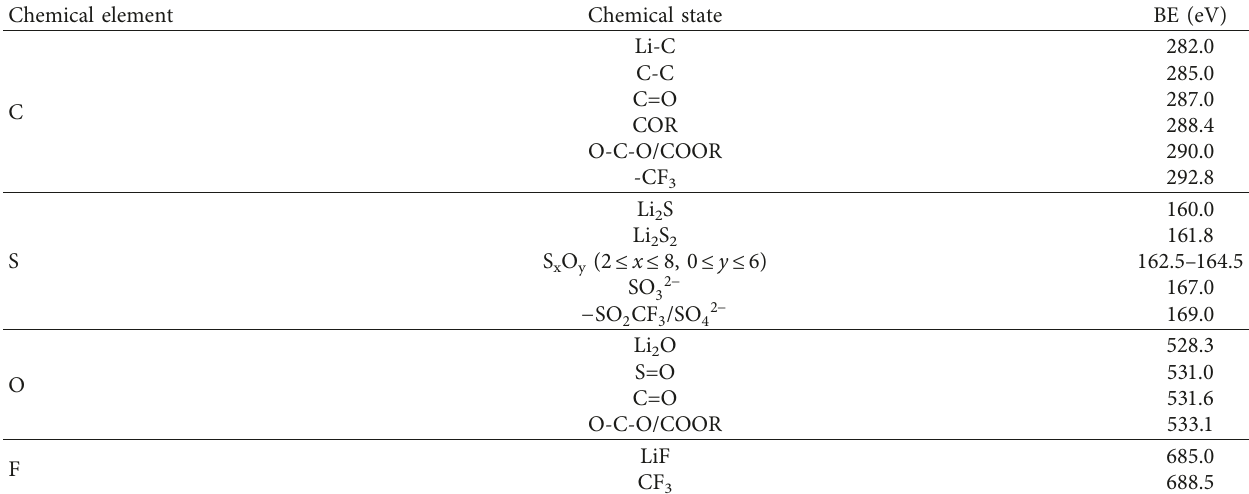
Table 1: Binding energy (BE) positions (eV) of the C-, S-, O-, and F-containing species from XPS spectra of a SEI layer formed after spontaneous passivation in DOL/TEGDME (7: 3) and (i) 1M Li[TFSI]; (ii) 1M Li[TFSI] with LiNO 3 ; (iii) 1M Li[TFSI] with polysulfides; and (iv) 1M Li[TFSI] with polysulfides and LiNO 3 , after sputtering (corresponding to Figure